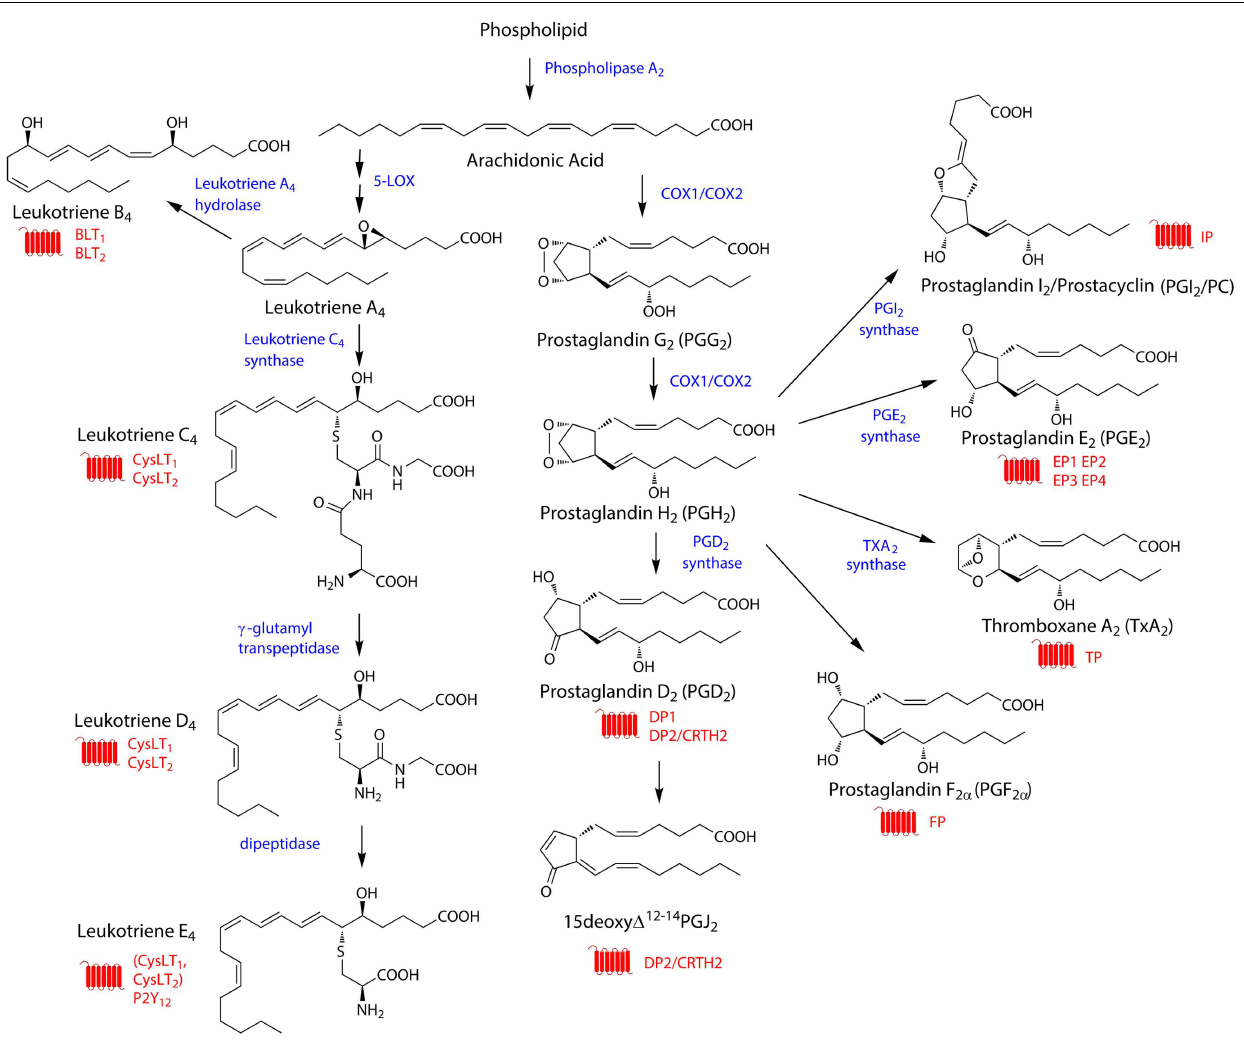
FIGURE 1 | General overview of synthesis pathways for eicosanoids .The biosynthetic pathway for the arachidonic acid-derived eicosanoids described in this article.The figure shows the structures of the relevant eicosanoids